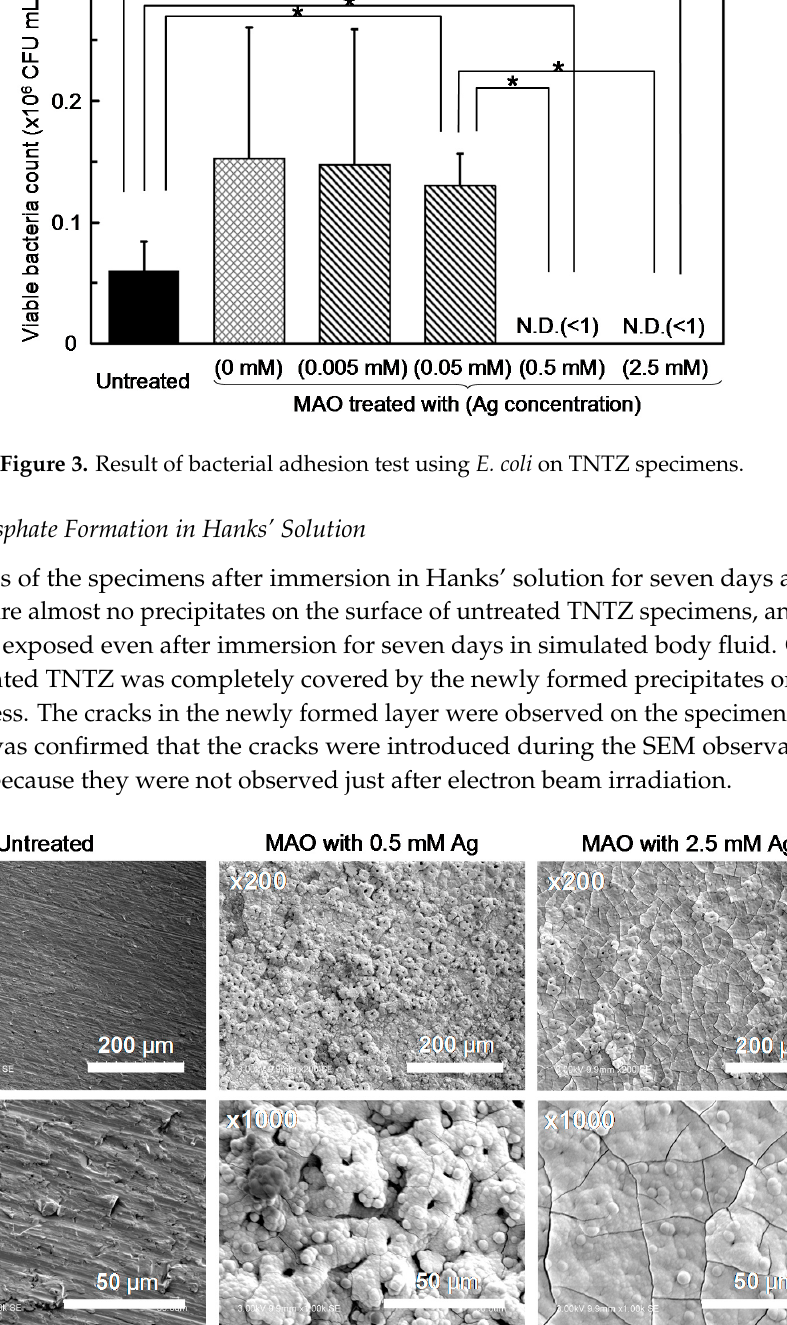
Figure 4. Scanning electron micrographs of specimens after immersion in Hanks ʹ solution for 7 days.